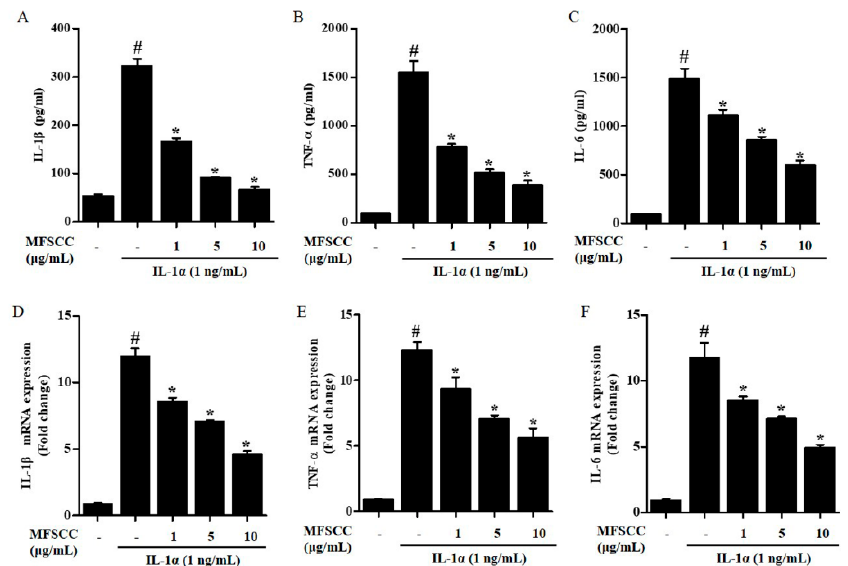
Figure 4. MFSCC attenuated the expression of pro-inflammatory cytokines in IL-1 α -stimulated primary chondrocytes. The expression of IL-1 β , TNF- α , and IL-6 was investigated by ELISA ( A – C ) and qRT-PCR ( D – F ). Rat primary chondrocytes were co-treated with MFSCC (0, 1, 5, and 10 µ g / mL) and 1 ng / mL interleukin-1 α for 24 h. The data results indicated as mean ± SEM (# p < 0.05 compared with the control group; * p < 0.05 compared with the IL-1 α group).